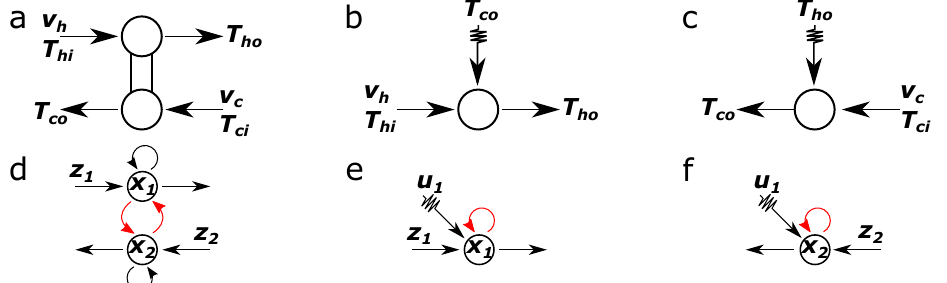
Figure 3. The grid diagram and state-space network representations of: a heat exchanger cell ( a , d ); a utility cooler ( b , e ); and a utility heater ( c , f ). Red edges denote loops in the network representation, which create a strongly connected component in each elementary building block of HENs. In the case of the heat exchanger cell, the hot and cold sides of the exchanger belong to the same component even though they also have their own intrinsic dynamics, as in the case of utility